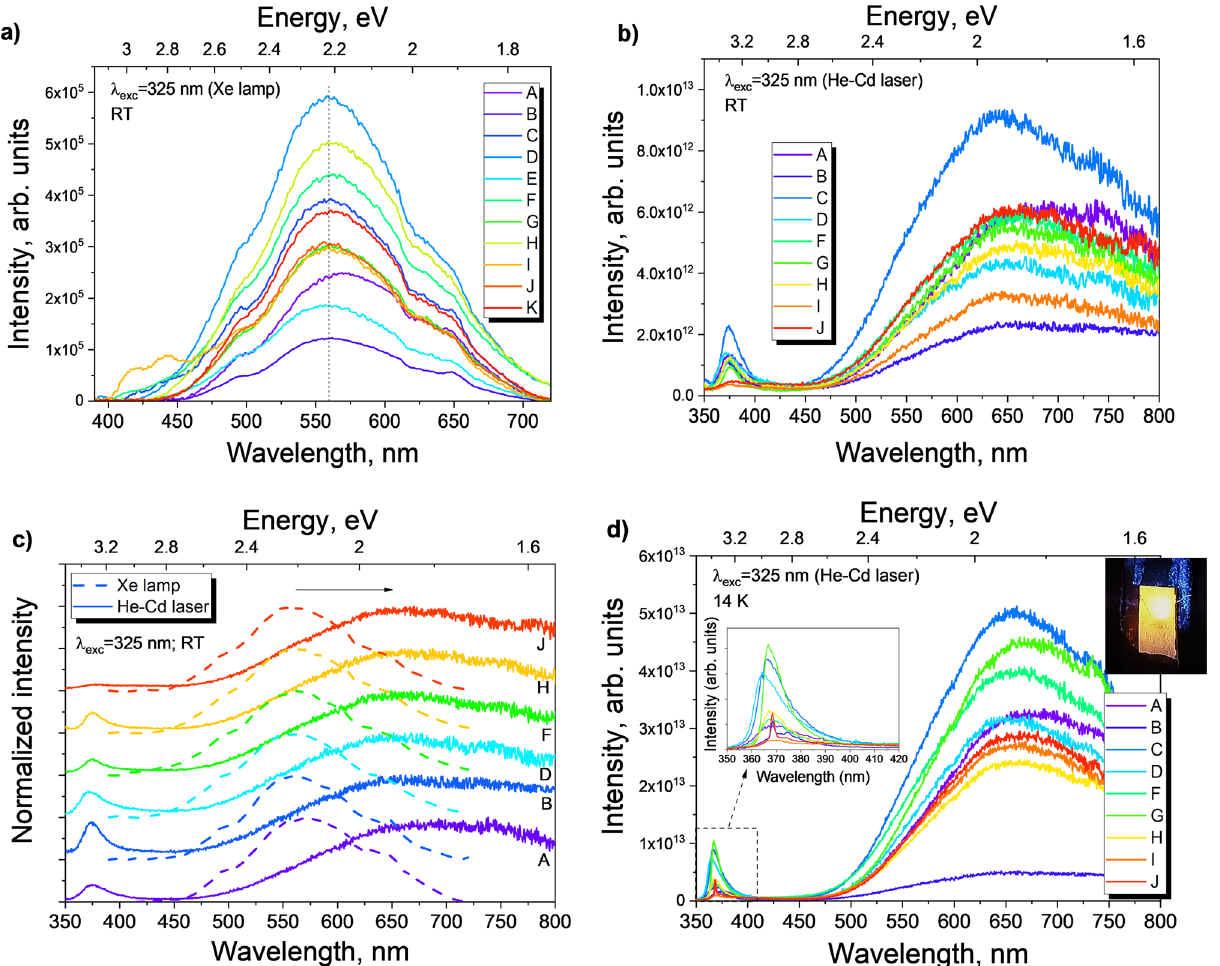
Figure 7. RT PL spectra of ( a ) all composites (profiles A to K) under 325 nm excitation of a Xe lamp and ( b ) selected composites probed with the 325 nm laser line of a He-Cd laser, showing a comparison of their absolute intensity. Note that in ( a ) a longpass filter L38 was employed, thus cutting off the signal below ~ 400 nm. ( c ) Comparison of normalized PL spectra for selected profiles under the same energy excitation (325 nm) but different excitation density conditions (lamp vs laser). The spectra were vertically shifted for clarity. ( d ) 14 K PL spectra of selected composites excited with the 325 nm laser line of the He-Cd laser. The insets correspond to an amplification of the UV region and a photograph of the orange/red emission at 14 K for profile C. Profile A corresponds to a continuous electrodeposition and profiles B to K correspond to pulsed electrodeposition. Pulsed electrodeposition profiles have the following relations: Increasing duty cycle (E-B-C-D), increasing (more negative) pulsed potential magnitude (F-B-G-H), and increasing pulse frequency (K-B-I-J). See Table 1 for complete information on